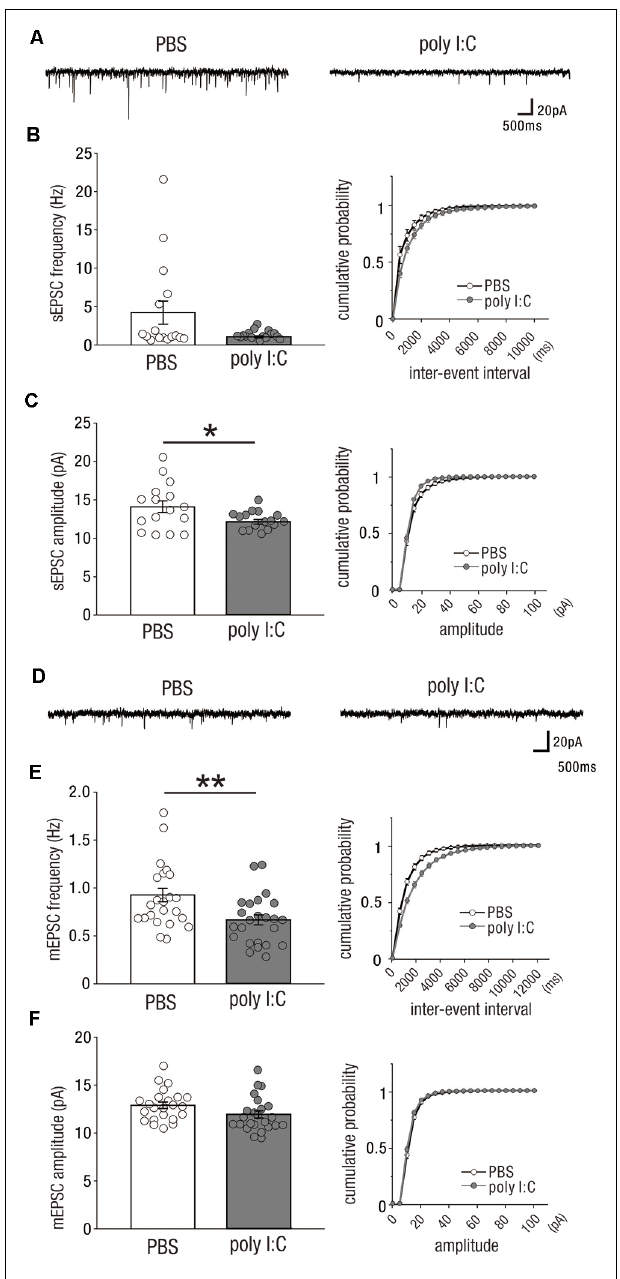
FIGURE 1 | Prenatal poly I:C treatment reduces excitatory synaptic inputs onto CA1 pyramidal cells in adulthood. (A) Representative data of spontaneous excitatory postsynaptic currents (sEPSCs) recorded from a CA1 pyramidal cell of a PBS-treated mouse (left) and poly I:C-treated mouse (right). (B) Left: the frequency of sEPSCs of poly I:C-treated mice showed a trend to be significantly lower than that of PBS-treated mice. Right: Cumulative probability of sEPSC frequencies shows a right-skewed curve in poly I:C-treated mice compared to that in PBS-treated mice. (C) Left: the amplitude of sEPSCs of poly I:C-treated mice was significantly smaller than that of PBS-treated mice. Right: cumulative probability of sEPSC amplitudes shows a left-skewed curve in poly I:C-treated mice compared to that in PBS-treated mice. (D) Representative data of miniature excitatory postsynaptic currents (mEPSCs) recorded from a CA1 pyramidal cell of a ( Continued )